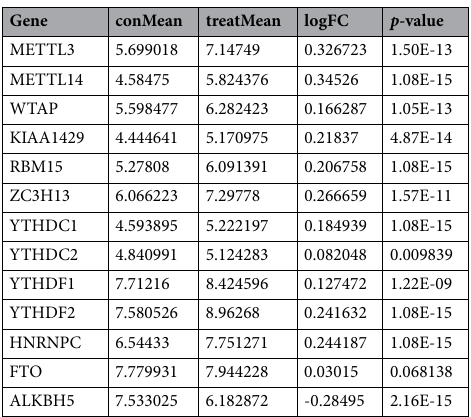
Table 1. Differential expression of m6A-related genes. Table shows the differential expression of all m6A- related genes in Ewing’s